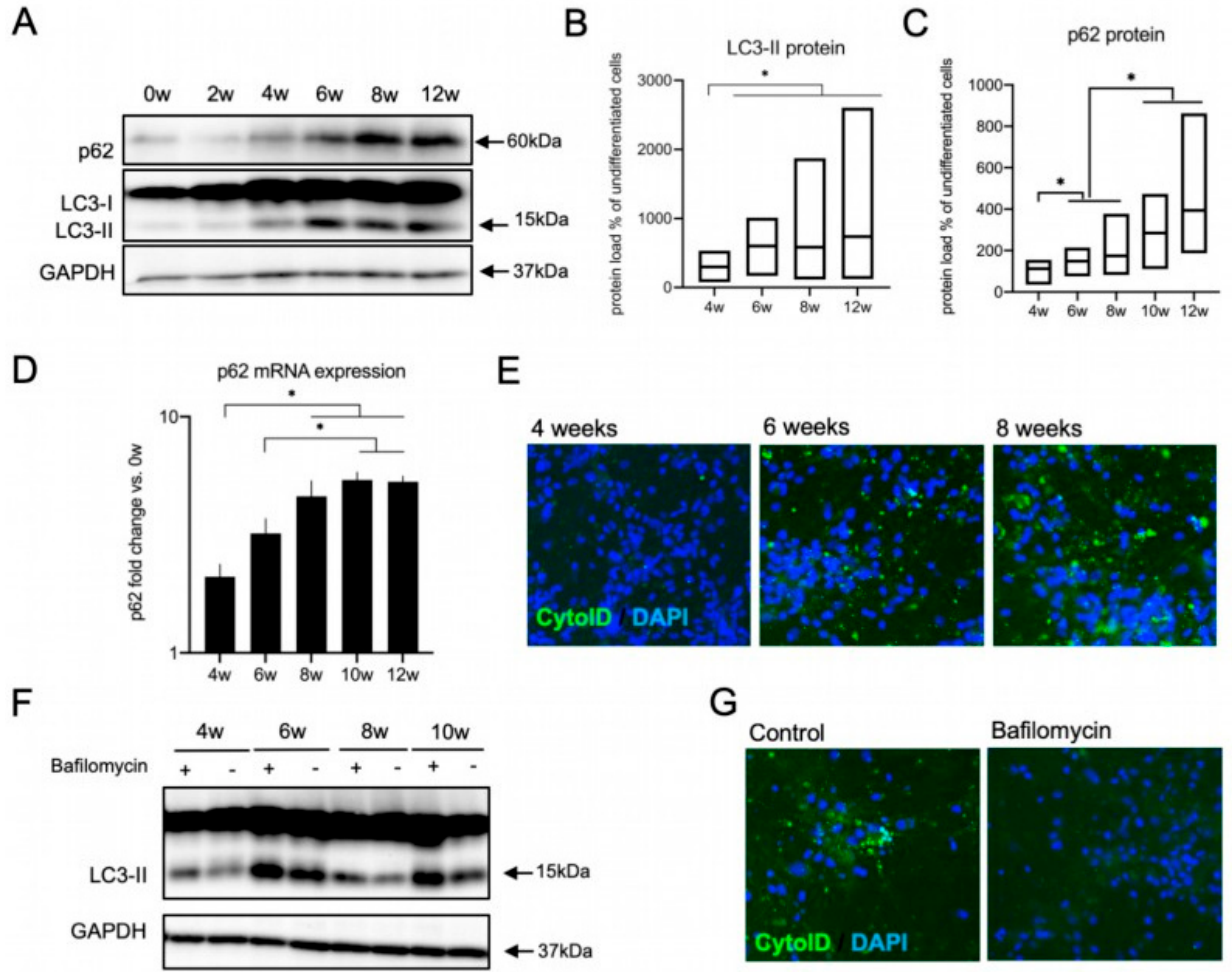
Figure 4. Upregulation of the autophagic machinery during neural differentiation. ( A – E ) Increase in the autophagic components with ongoing neural differentiation of lt-NES cultures. ( A ) Representative Western blot analysis of LC3-II and p62 protein expression along differentiation. ( B , C ) Quantification of Western blot data of LC3-II ( B ) and p62 ( C ) protein levels in lt-NES cells differentiated for up to 12 weeks. Data are presented as percentage of LC3-II levels in undifferentiated cells ±SEM (floating bar represents the range of the SEM value; the mean is marked within each bar). All samples were normalized to GAPDH as a loading control. Statistical significance was assessed by ratio paired t-tests (* = p < 0.05; n = 8). ( D ) Expression of the adaptor protein p62 increases along lt-NES neural differentiation. Data are normalized to GAPDH mRNA levels ( n = 6 per differentiation time point). Significant difference among means was confirmed by one-way ANOVA ( p = 0.0001) followed by Bonferroni’s multiple comparison tests (* = p < 0.05). ( E ) Representative images of 4-, 6-, and 8-week-differentiated lt-NES cells stained with a CYTO-ID ® Autophagy detection kit. Nuclei were counterstained with DAPI. ( F , G ) Autophagic flux is active in differentiating lt-NES cells. ( F ) Autophagic flux assessment across lt-NES cells differentiated for up to 10 weeks, showing active autophagic flux at all differentiation stages. Cells were treated with Bafilomycin (400 nM) for 4 h. ( G ) Representative images of 10-week-differentiated lt-NES cells treated with Bafilomycin and stained with CYTO-ID ® Autophagy detection kit. Nuclei were counterstained with DAPI. 3.5. Autophagic Flux Does Not Contribute to the Acute Oxidative Stress Response in Differentiated lt-NES Cells Since p62 is a known regulator of NRF2 by mediating the autophagic degradation of KEAP1, we were wondering whether the increase in autophagosomal machinery is affecting the NRF2 pathway in differentiated lt-NES cells and if it contributes to the dynamic stress response along differentiation in an NRF2-dependent or independent manner. To tackle this question, we blocked autophagy for a continuous time frame and